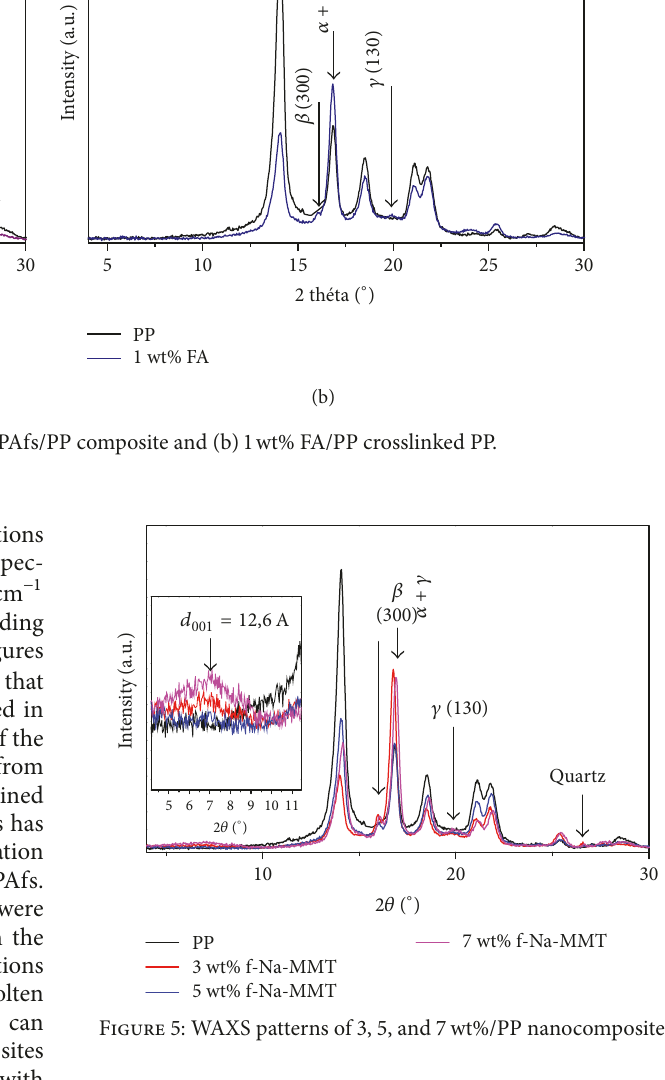
can be found, which can be indexed as (110) at 2 𝜃 ( ∘ ) = 14.07, (040) at 16.84, (130) at 18.5, (111) at 21.11, and (041) at 21.8 and (060), (220) at about 25.3 and 28.5, respectively, without any additional diffraction